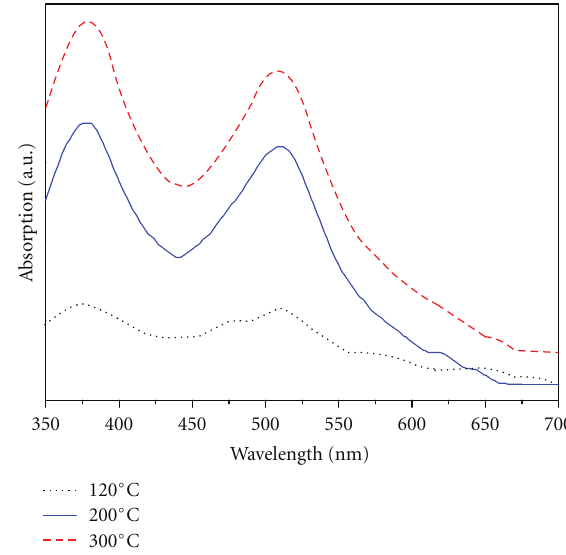
F 2: TG� for GPTS- and MPTS-modi�ed TiO